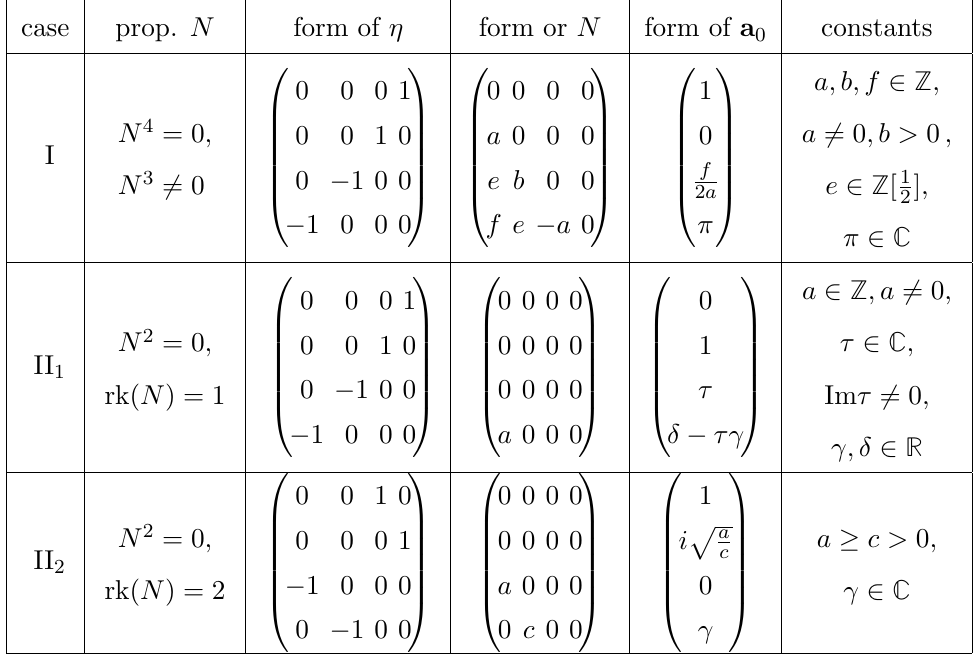
Table 4 . Classi(cid:12)cation of occurring in(cid:12)nite order monodromies and vectors a 0 for the one-modulus case